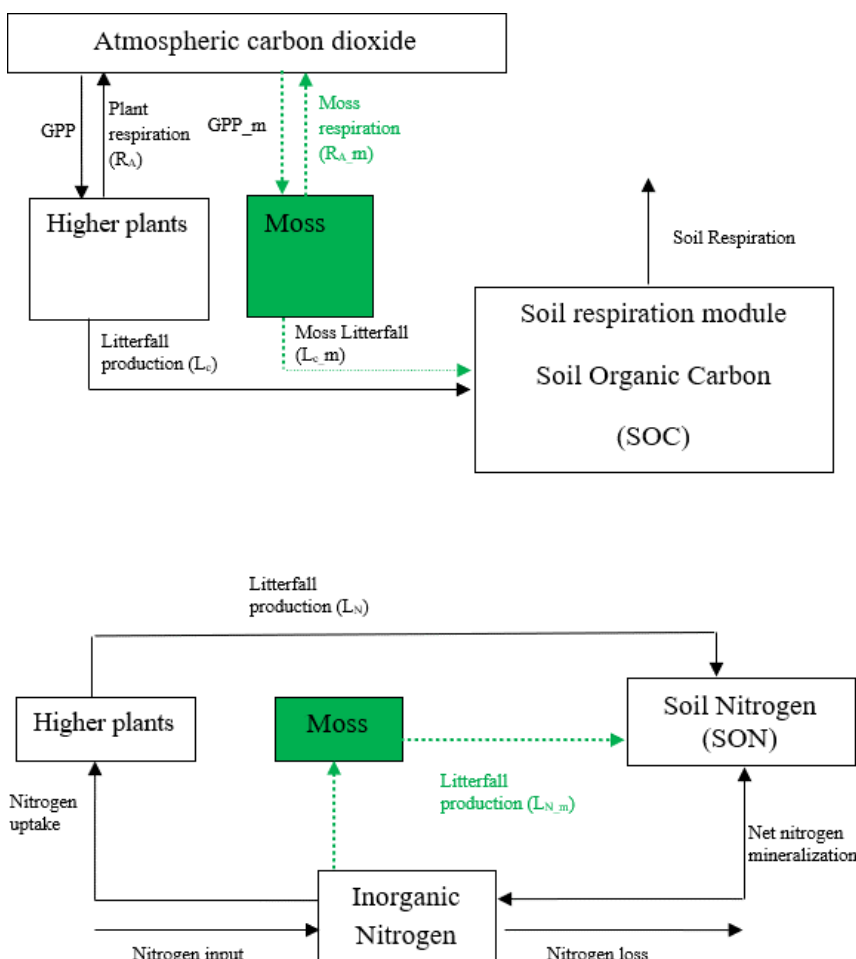
Figure 1. Schematic diagram of TEM_Moss: green dashed arrows are new carbon and nitrogen fluxes, representing moss production, moss respiration, and litterfall of moss. Black arrows were in TEM 5.0 (Zhuang et al.,